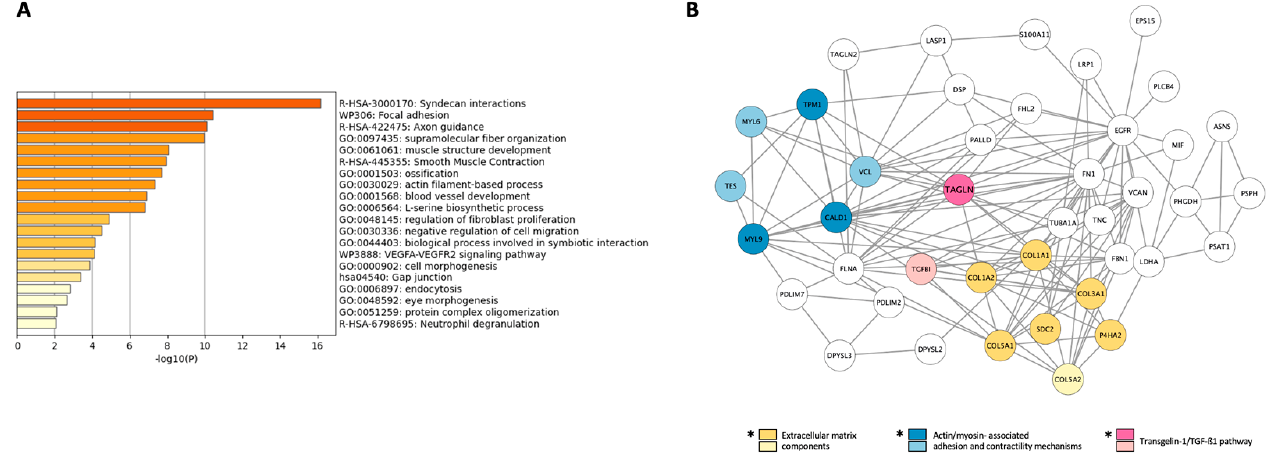
Figure 4. Transgelin 1 (TAGLN)-mediated processes are improved in hBP-solo. ( A ) Top-level gene ontology (GO) analysis and ( B ) Interaction map of the 51 proteins quantitatively enriched in hBP-solo. *: Top-20